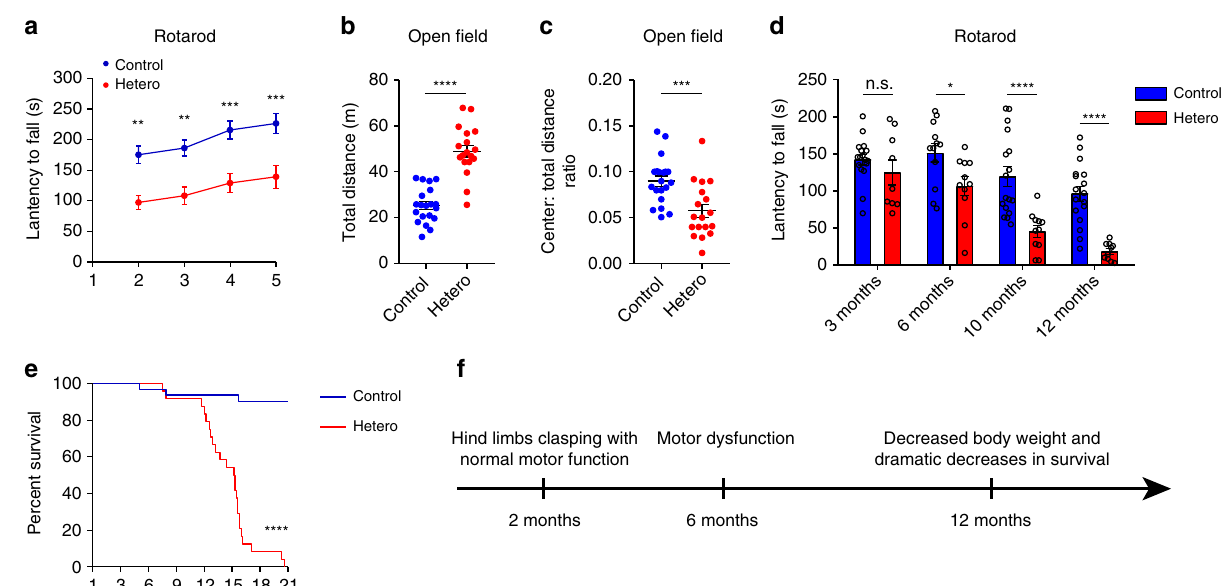
Fig. 4 GFP-PR 28 heterozygous mice show progressive motor de fi cits and anxiety-like behaviors. a Latencies to fall from the accelerated rotating beams of male control and GFP-PR 28 heterozygous mice at 6 months of age. Two-way ANOVA, Bonferroni post hoc test; n = 18, 18 mice. b , c Open- fi eld test showing the ratio of time in the center area and total ambulatory distance of male control and GFP-PR 28 heterozygous mice at 6 months of age. Two-tailed t test, n = 20, 18 mice. d Latencies to fall from the accelerated rotating beams of control and GFP-PR 28 heterozygous mice at 3, 6, 10, and 12 – 16 months of age. Two-way ANOVA, Bonferroni post hoc test; 3 months, n = 17, 9 mice; 6 months, n = 12, 11 mice; 10 months, n = 17, 11 mice; 12 – 16 months, n = 17, 10 mice. e Kaplan – Meier survival curve of control and heterozygous mice. Gehan – Breslow – Wilcoxon test, n = 32, 24 mice. f Diagram of the disease progression of GFP-PR 28 heterozygous mice. All data are displayed as mean ± s.e.m. * P < 0.05, *** P < 0.001, **** P < 0.0001, n.s. not signi fi at 12 months of age, the body weight of male heterozygous mice signi fi cantly decreased as compared with control mice (Fig. 3c).